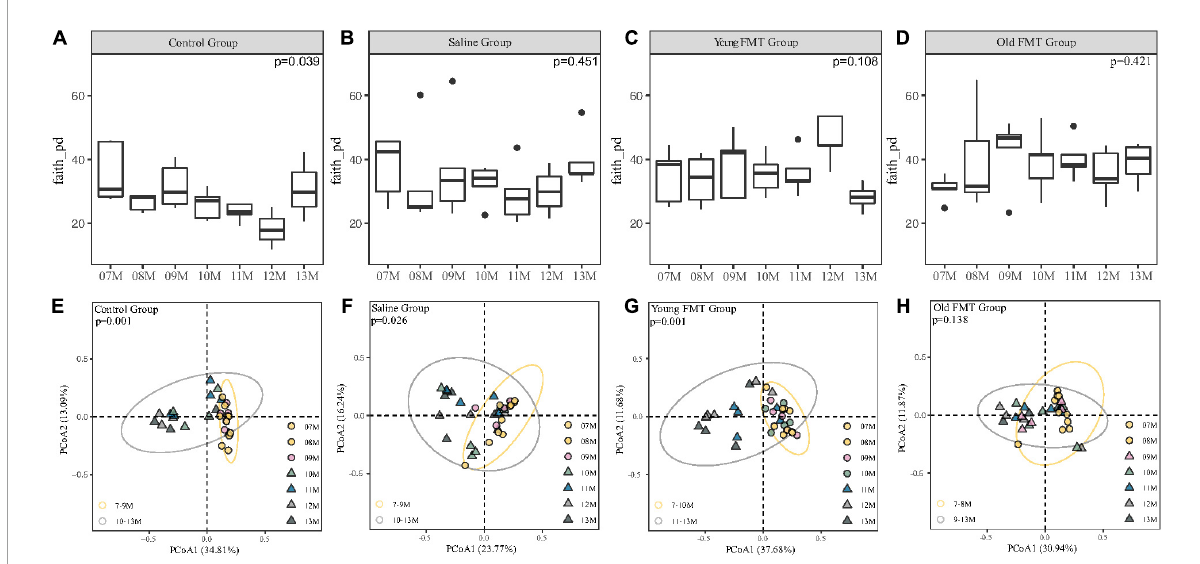
FIGURE4 Effects of fecal microbiota transplantation (FMT) on Alpha and Beta diversity during aging. (A–D) The vertical comparison of Faith Phylogenetic Diversity index from 7 to 13 ◦ months old within group (Kruskal-Wallis H test). (E–H) Principal component analysis of Unweighted unifrac distance from 7 to 13 ◦ months old within group (PERMANOVA, Yellow Circle: the months of age before the turning point; Gray Circle: the months of age after the turning point). P -value was shown on the top left-hand corner. 7–11 ◦ months old, n = 5 per group; 12 ◦ months old, n = 3 (Control group), 4 (Saline group), 5 (Young FMT group), 5 (Old FMT group); 13 ◦ months old, n = 4 (Control group), 5 (Saline group), 5 (Young FMT group), 4 (Old FMT